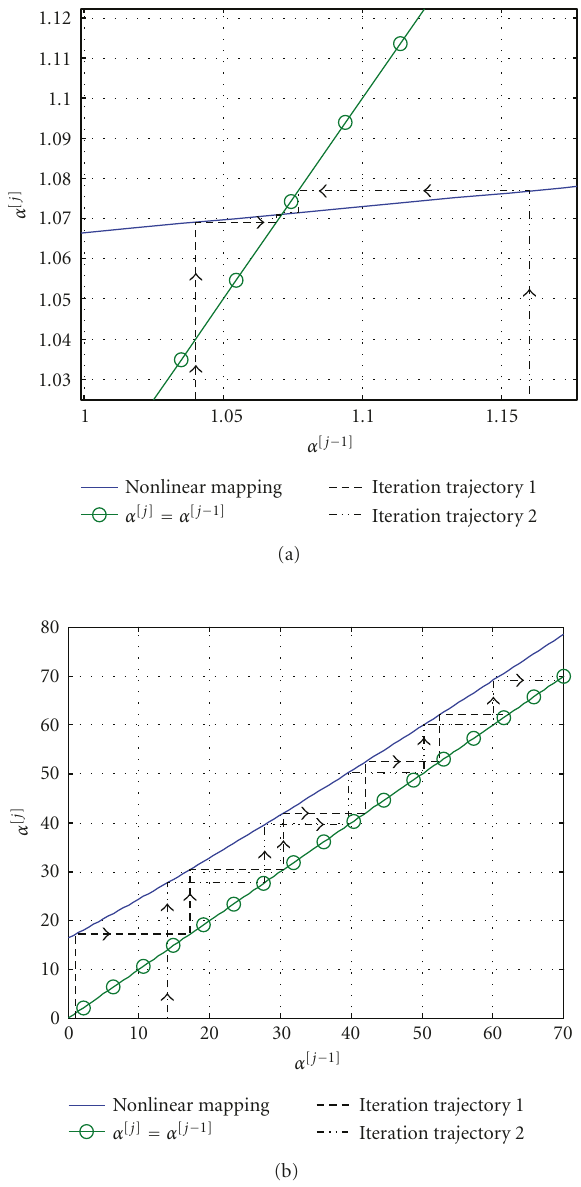
Figure 6: Evolution of the two representative solution trajectories for two cases: (a) { α [ j ] } converges, (b) { α [ j ] }